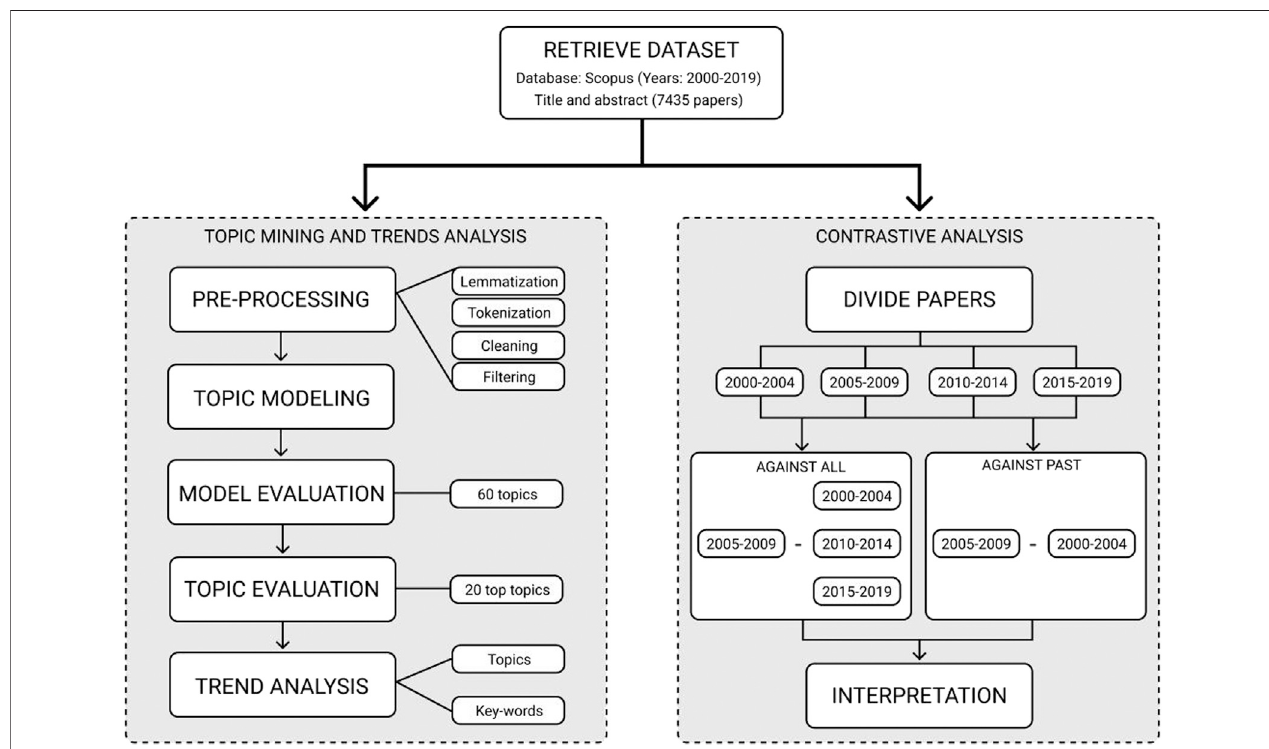
FIGURE 2 | Research